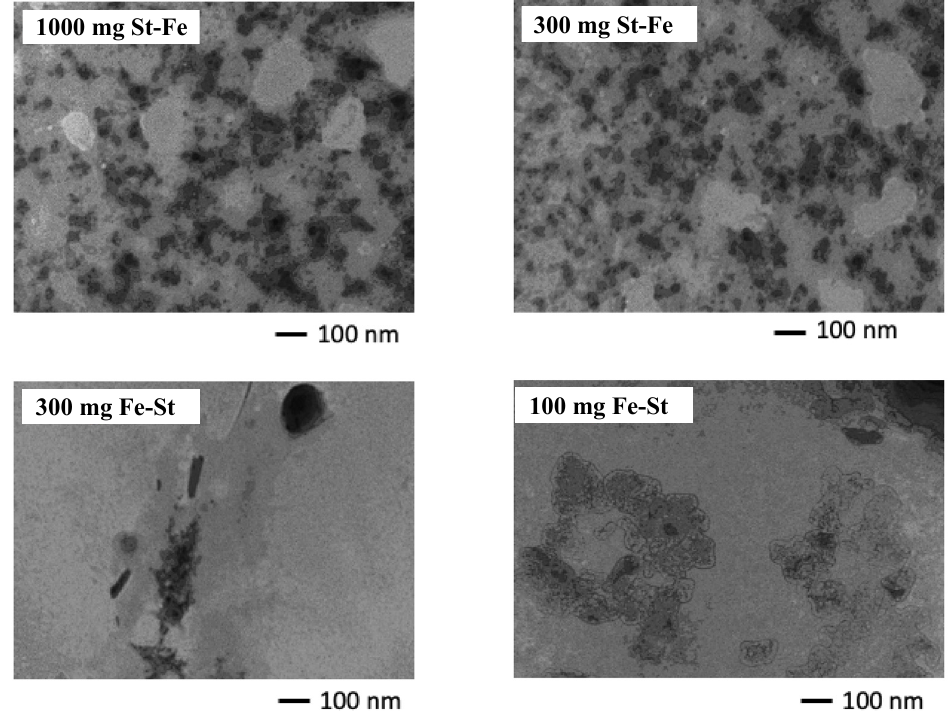
Figure 2. TEM imaging of St–Fe and Fe–St NPs as identified above.